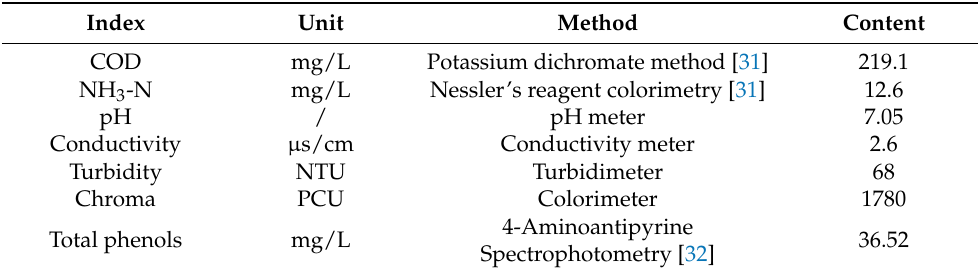
Table 1. Water quality analysis of coal chemical biochemical